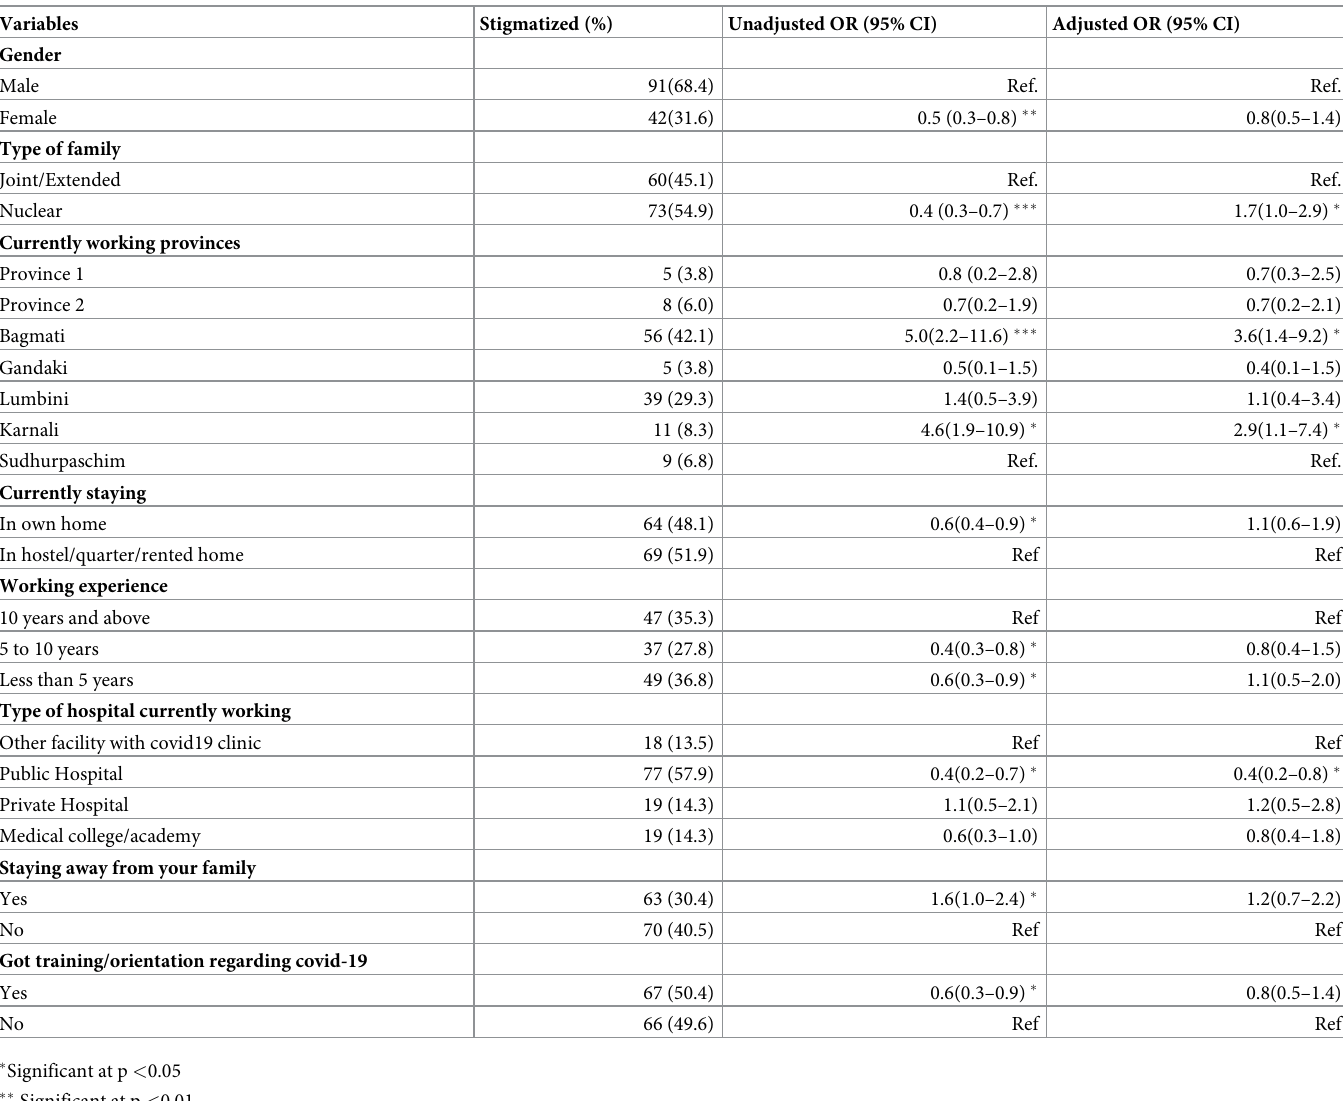
Table 5. Association of stigma with independents